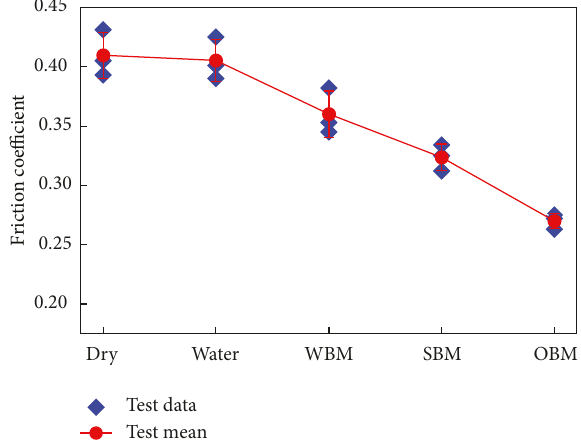
Figure 3: Corresponding sliding friction coefficients of different lubricant